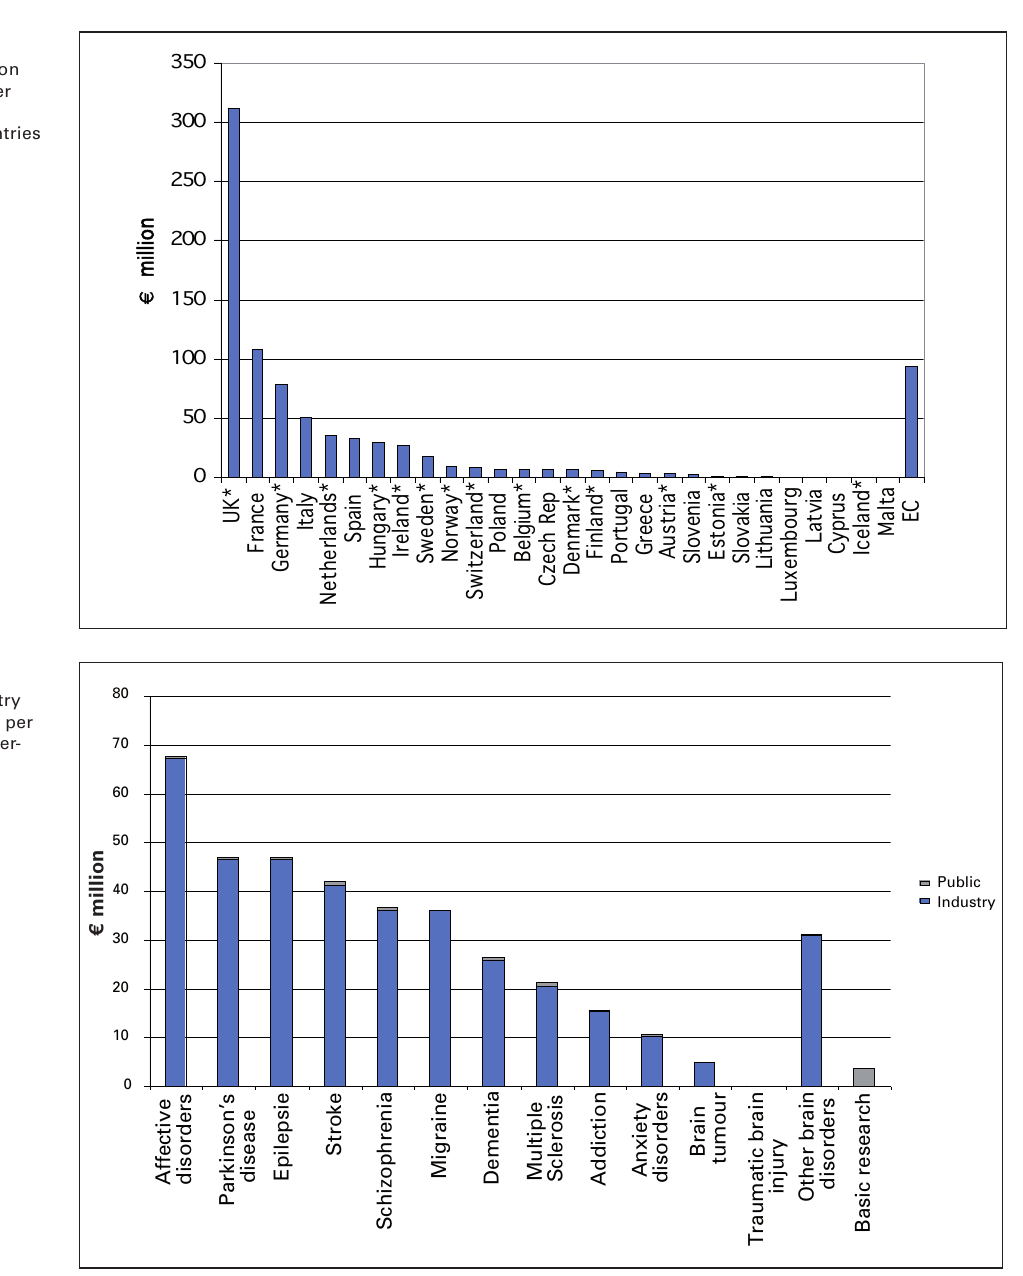
Figure 3 Public and industry research funding per disorder in Switzer- land